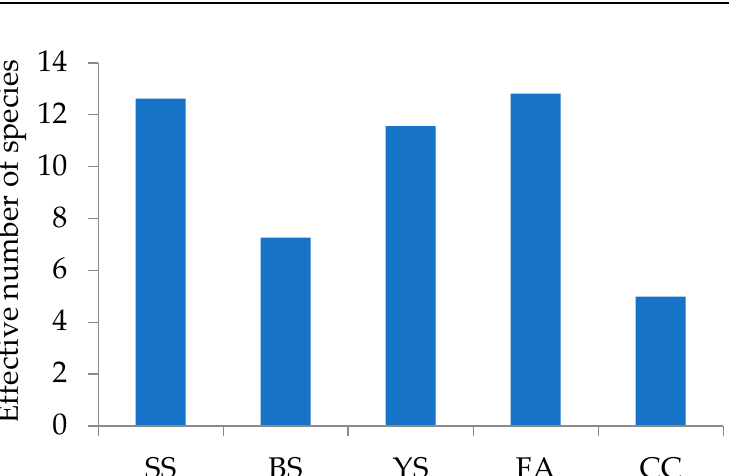
Figure 4. True alpha diversity of Trichoptera in the Sierra de Juárez, Oaxaca, Mexico.